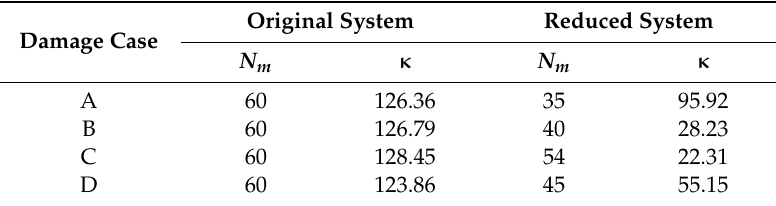
Table 2. The number of equations ( N m ) and the corresponding condition number ( κ ) of the original and reduced CMSE systems for damage cases A to D. Figure 13. Damage identification results of damage case C at a 3% level of noise, with an iterative Tikhonov solution: ( a ) CMSE method; ( b ) RCMSE method.